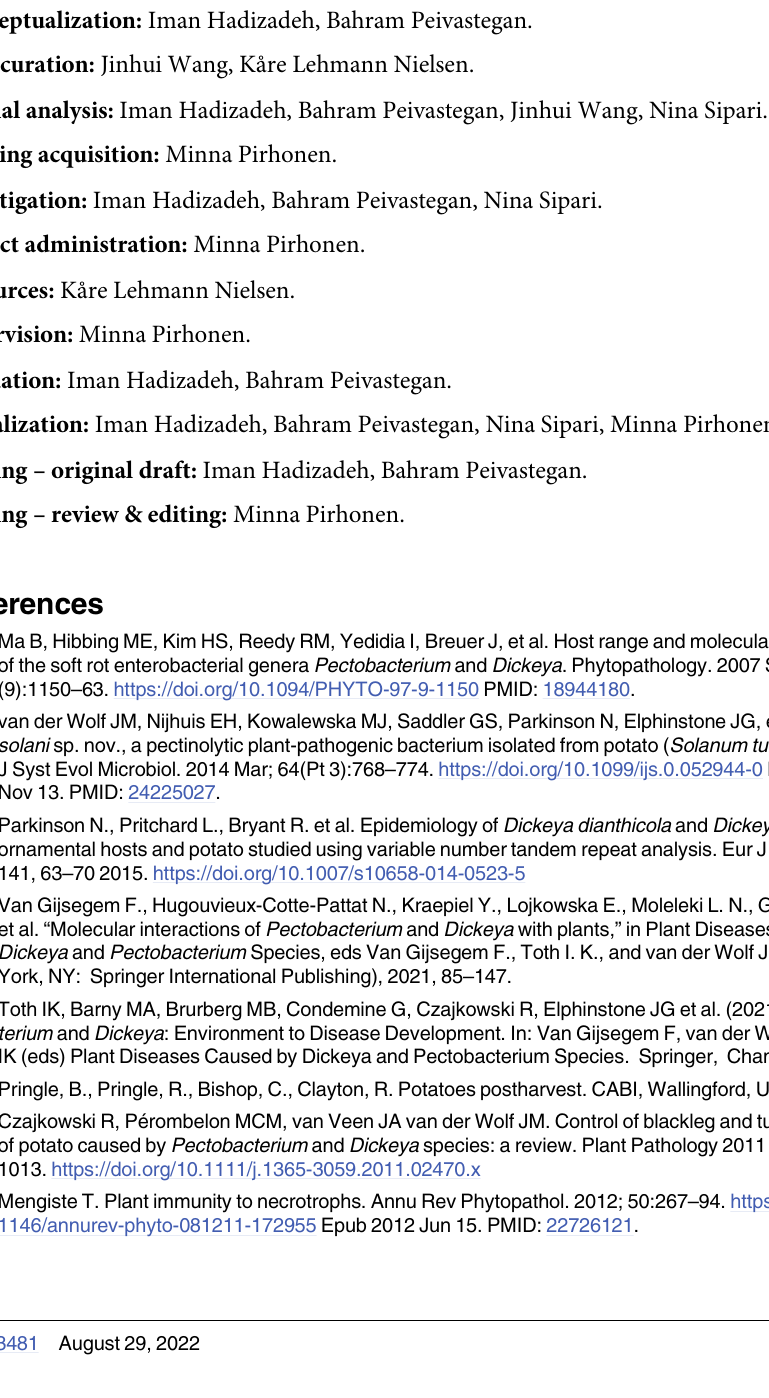
S6 Table. Identity of the genes used for heatmap analysis to visualize SA, JA and ET path- ways in inoculated